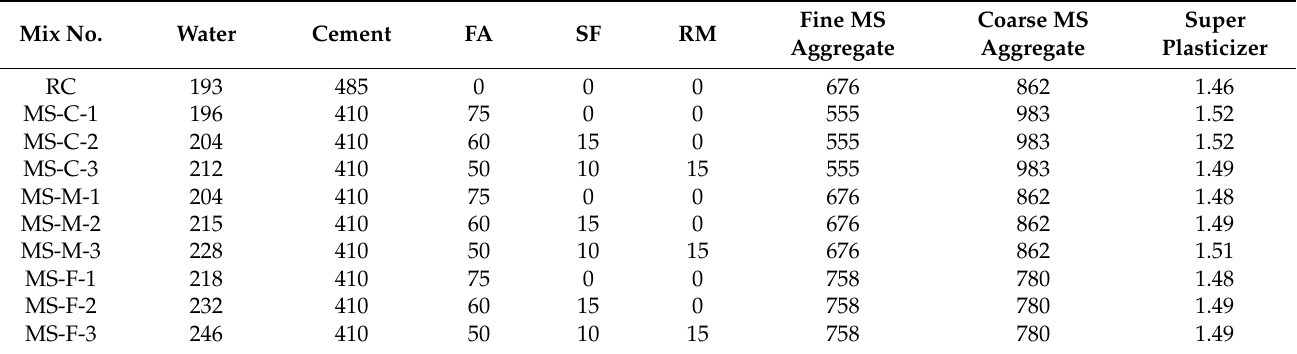
Table 2. HPC material proportions (kg/m 3